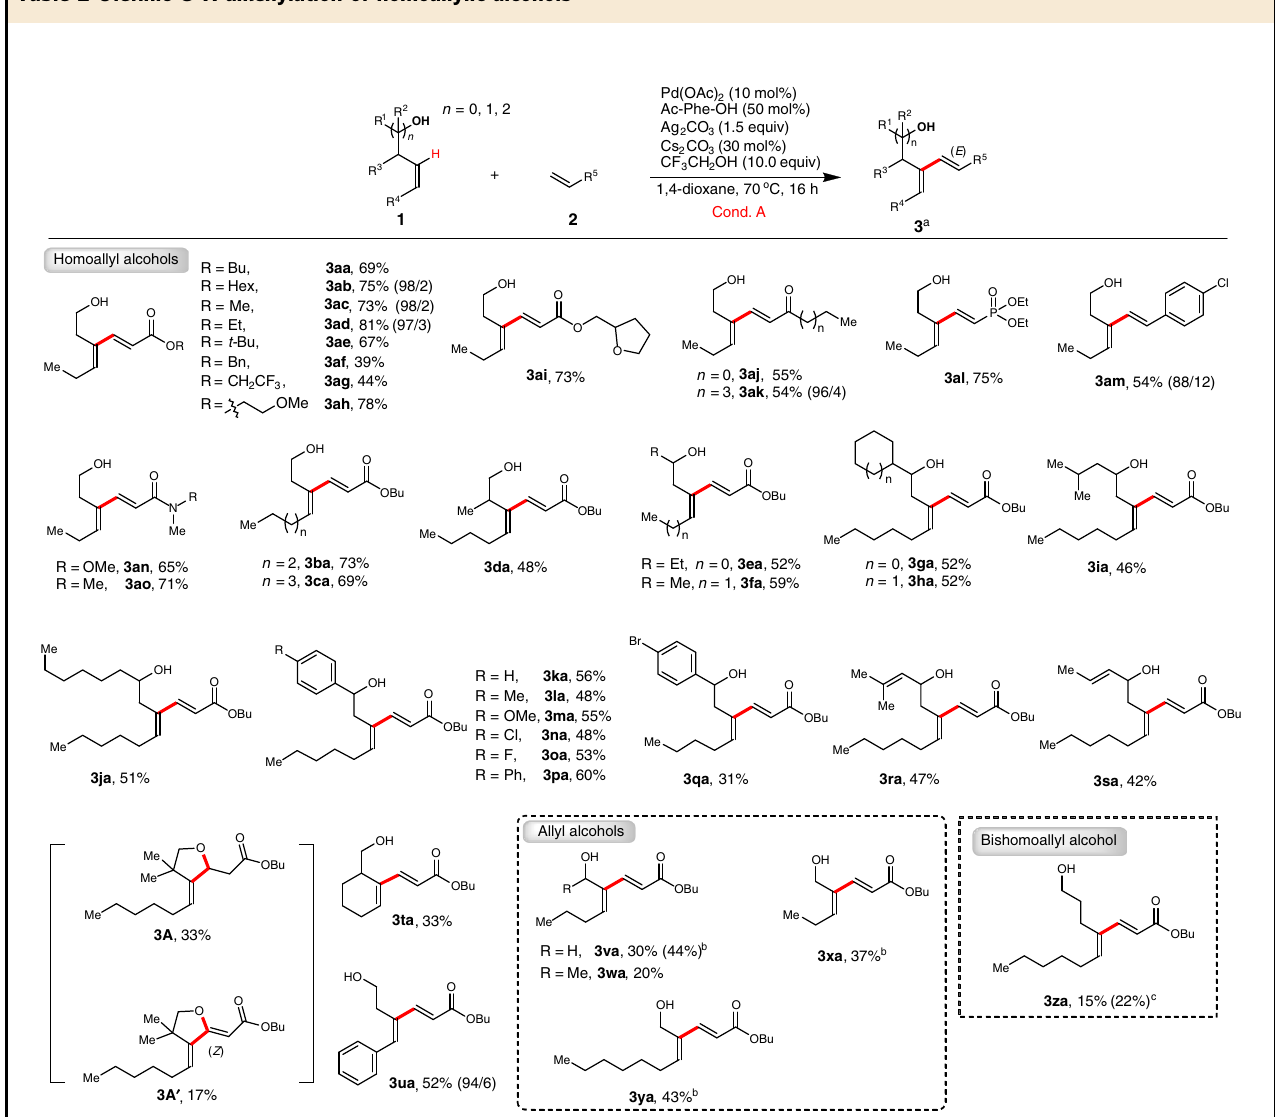
Table 2 Ole fi nic C – H alkenylation of homoallylic alcohols